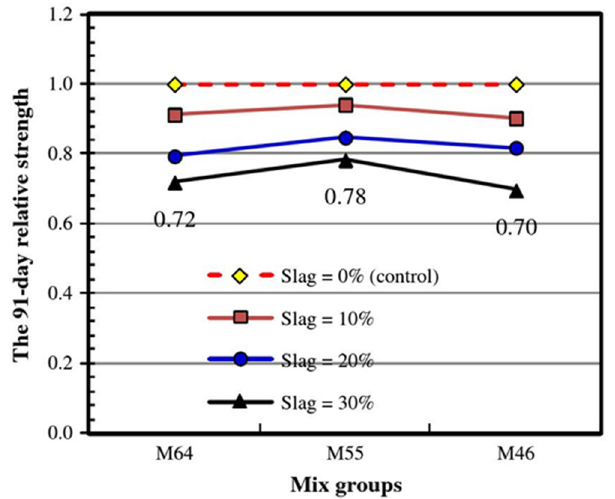
Figure 2. The 91-day relative compressive strengths of slag-containing CLSMs, compared to a slag-free control mixture [74].